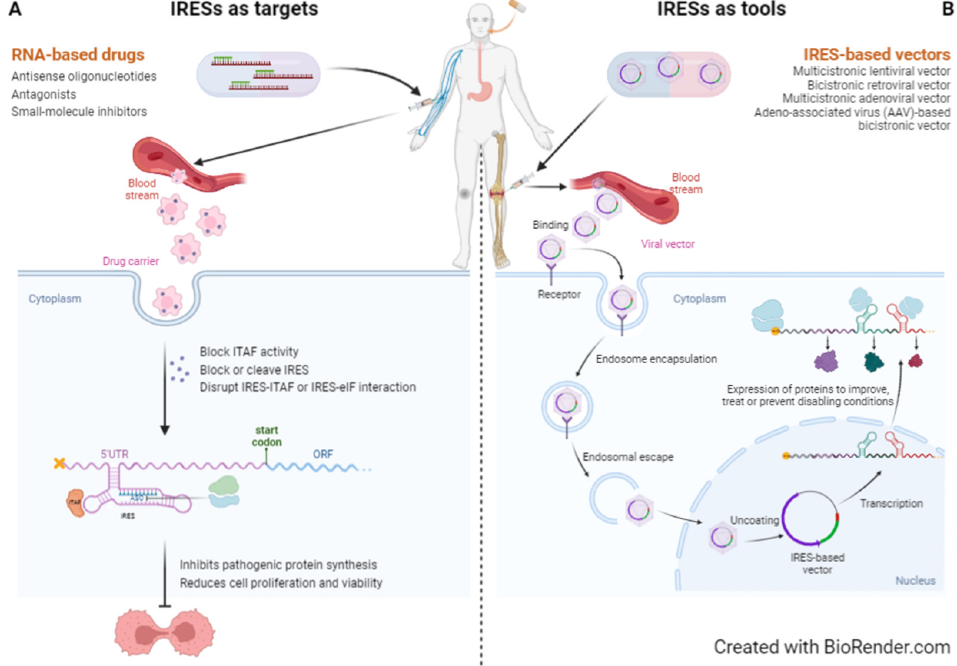
Figure 3. Mechanism of action of RNA-based therapies using internal ribosome entry sites (IRESs) as targets or tools. ( A ) IRESs as targets. RNA-based drugs, which can be composed of different RNA molecules, such as antisense oligonucleotides (ASOs), antagonists, or small-molecule inhibitors, are delivered into the bloodstream and carried to specific cells. Such RNA compounds bind to the mRNA and promote alterations in the IRES-mediated translation of pathogenic proteins, by blocking or cleaving the IRES structure, disrupting the interactions between the IRES element and both the ribosome and IRES trans -acting factors (ITAFs) and blocking the activity of ITAFs. These modifications lead to protein synthesis impairment, which may be crucial for the treatment or prevention of several pathologies, besides cancer. ( B ) IRESs as tools. Circular RNAs with IRESs, and several IRES-based viral vectors, have been used to produce non-pathogenic proteins with a therapeutic role. These vectors are injected into the bloodstream and then bound to specific cells. Once expressed, they